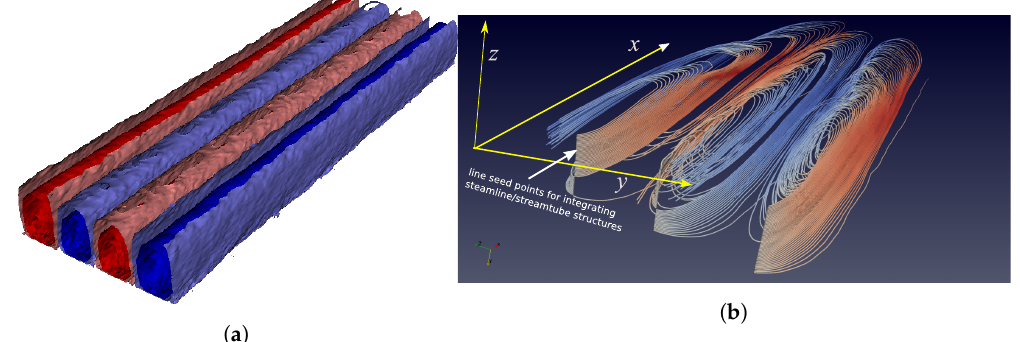
Figure 6. 3D normalized POD mode, m = 0 ( a ) Isosurface levels of streamwise POD mode for ϕ u m √ λ m / U ∞ ( b ) Streamtubes of vector streamwise POD mode for ϕ u , v , w m √ λ m / U ∞ .